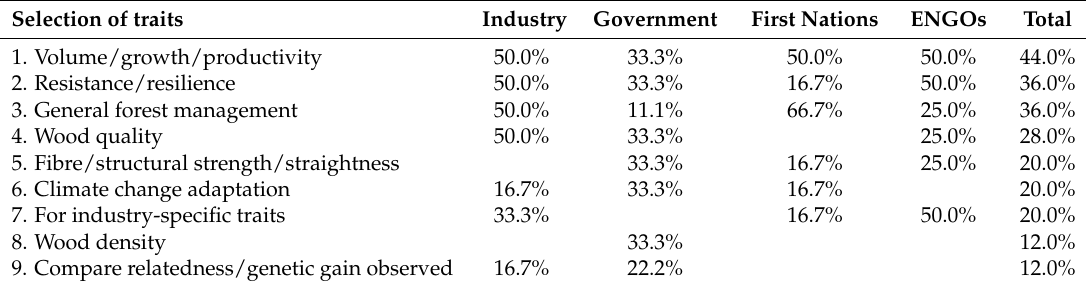
Table 7. Desirable traits where MAS could facilitate selection, and represented as a proportion of each group and by the total sample population, calculated by using relative frequencies.